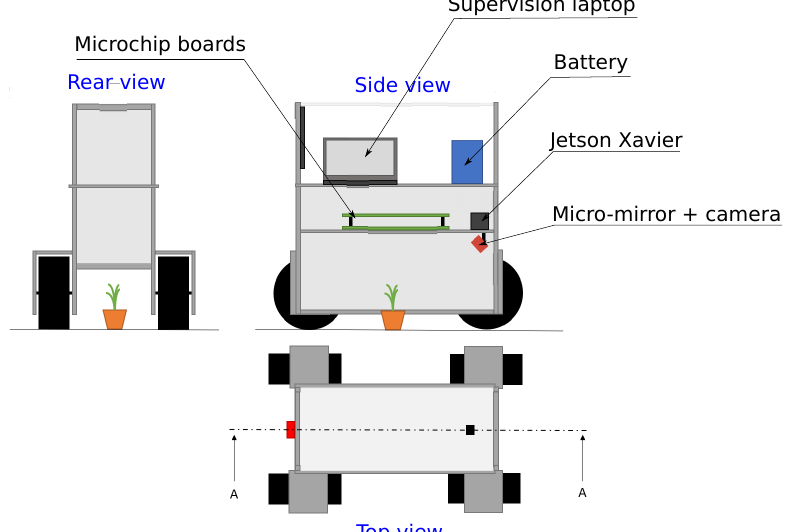
Figure 1. Mobile robot prototype overview.